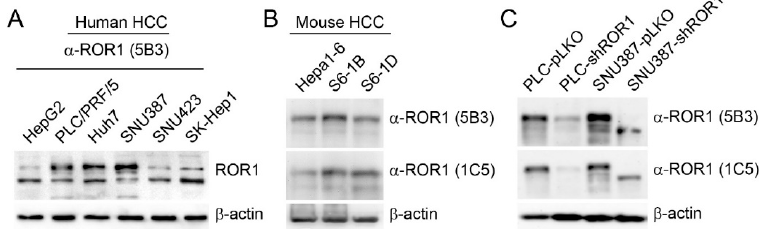
Figure 3. Expression of ROR1 in human and mouse HCC cell lines. ( A ) Western blotting analysis of ROR1 expression in human HCC cells. ROR1 was detected with 5B3 monoclonal antibody. ( B ) Western blotting analysis of ROR1 expression in mouse HCC cells. Both 5B3 and 1C5 antibodies were used to detect ROR1 in mouse HCC cell lines. ( C ) Specificity of ROR1 antibodies was tested in shRNA ROR1-knockdown and control clones. β -actin was used as a loading control.